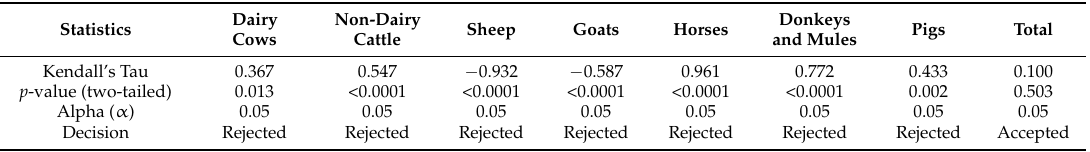
Table 4. Trend analysis of South African enteric emissions from 1990 to